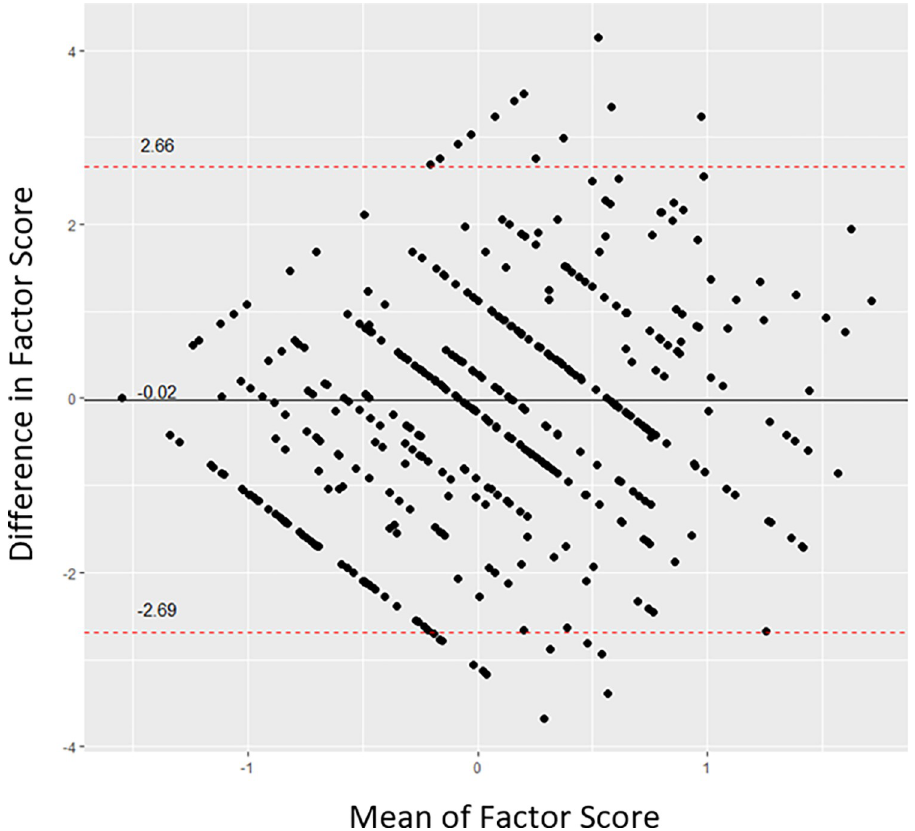
Fig 6. Bland-Altman plot of agreement between the CAT version and the fixed-length version with 12 items of ENRICh.